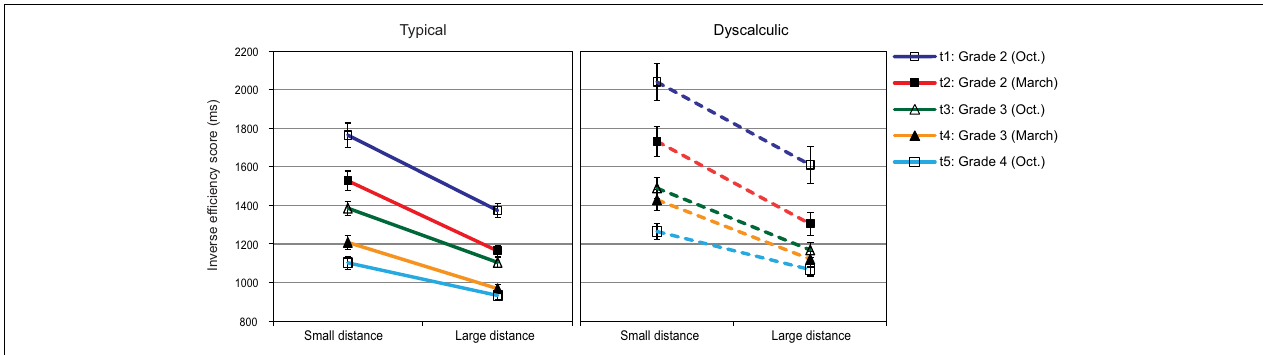
FIGURE 5 | Magnitude comparison: Mean IE-scores (SEs as error bars) for small and large numerical distance items at each assessment point.